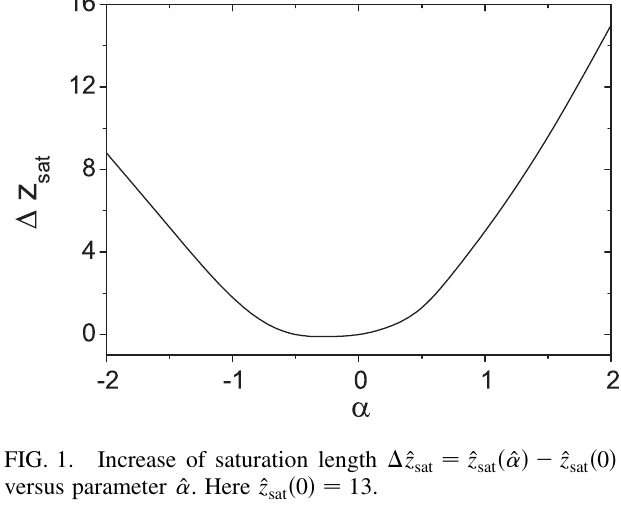
FIG. 1. Increase of saturation length (cid:3)^ z